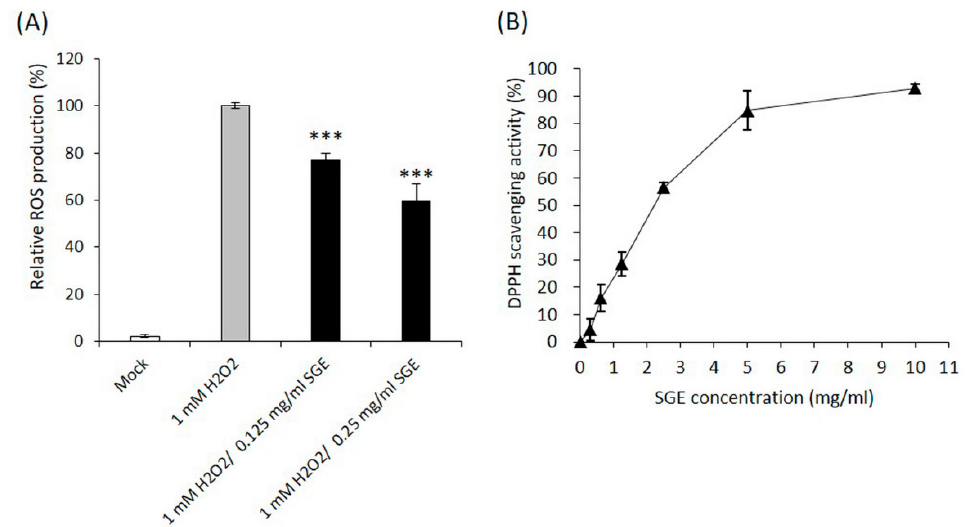
Figure 1. Antioxidant activities of SGE. ( A ) CCD-966SK cells were treated with 1 mM H 2 O 2 to induce ROS production (grey bar). Cells were co-treated with 1 mM H 2 O 2 and 0.125 or 0.25 mg/ml of SGE (black bars) to detect the antioxidant effect, or were left untreated as a negative control (Mock, white bar). Relative reactive oxygen species (ROS) production by different treatments was calculated in comparison with that of treatment with 1 mM H 2 O 2 (100%). ( B ) The DPPH radical scavenging activity was evaluated by using 0, 0.3125, 0.625, 1.25, 2.5, 5 and 10 mg/ml of SGE. SGE exhibited DPPH scavenging properties in a dose-dependent manner. ***, P < 0.001 versus 1 mM H 2 O 2 . SGE, Sargassum glaucescens extracts.